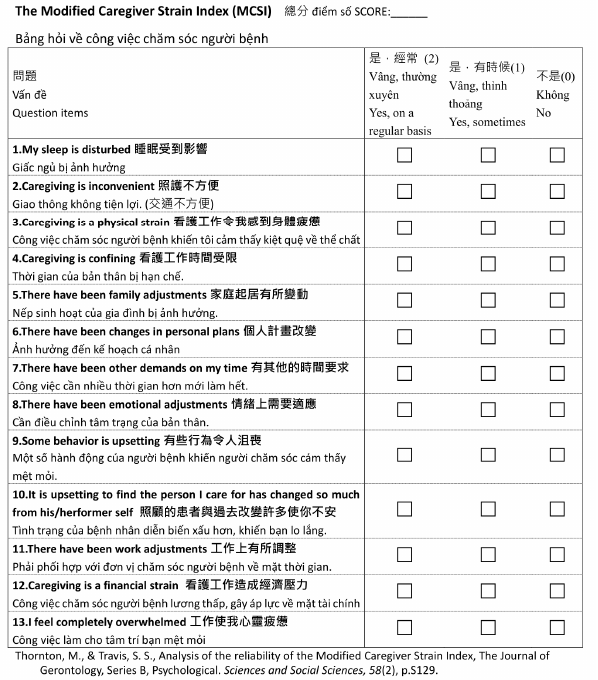
Figure A1. Vietnamese Version of Modified Caregiver Strain Index Revised 2003 [24].